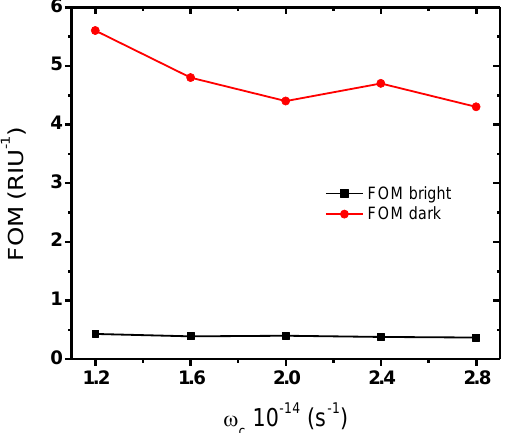
Figure 8. FOM values varying the collision frequency from 1.2 to 2.8 × 10 14 s −1 for the dark (red circles) and bright (black squares) modes respectively (α = 30 nm). Continuous lines are guide-to-the-eye